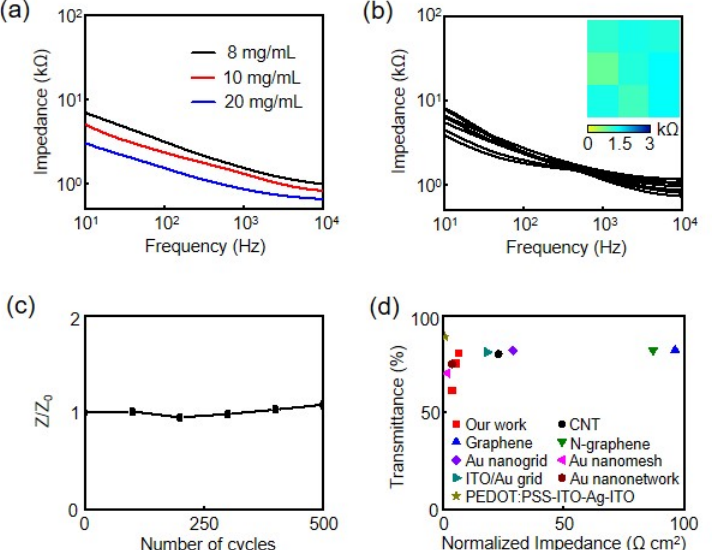
Figure 3. ( a ) Impedance plot of the Ag NW microelectrodes. ( b ) Impedance spectra of all 9 microelectrodes in a 9-channel Ag NW MEA. ( c ) Variation of impedance versus stretching cycle for Ag NW microelectrodes at a strain of 10%. Z 0 is the initial impedance, whereas Z represents the impedance at a specific stretching cycle. The results are averaged over 5 devices. ( d ) Normalized impedance of Ag NW microelectrodes versus transmittance compared to major reported flexible transparent microelectrodes such as CNT [14], graphene [16], nitrogen-doped graphene (N-graphene) [40], Au nanogrid [17], Au bilayer nanomesh [41], ITO/Au grid [42], Au nanonetwork [18], and PEDOT:PSS-ITO-Ag-ITO [20].